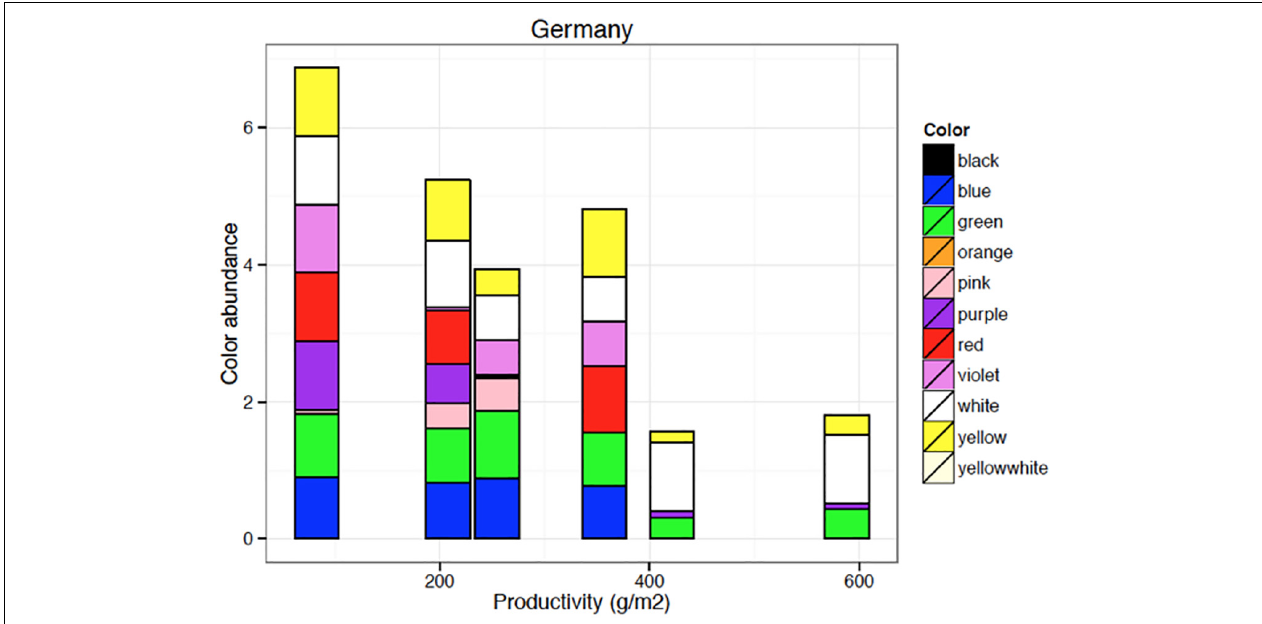
FIGURE 6 | Flower color abundance of plant species growing on sites of various productivity. Blue and red flowering species (as seen by human vision) disappear from the plant communities with increasing site productivity. Data shown here are based on 364 plots of 1 m × 1 m area organized in six systematic grids across a local productivity gradient in mesic temperate grassland close to Bayreuth University in Germany, part of the Herbaceous Diversity Network HERBDIVNET (see details in Fraser et al.,